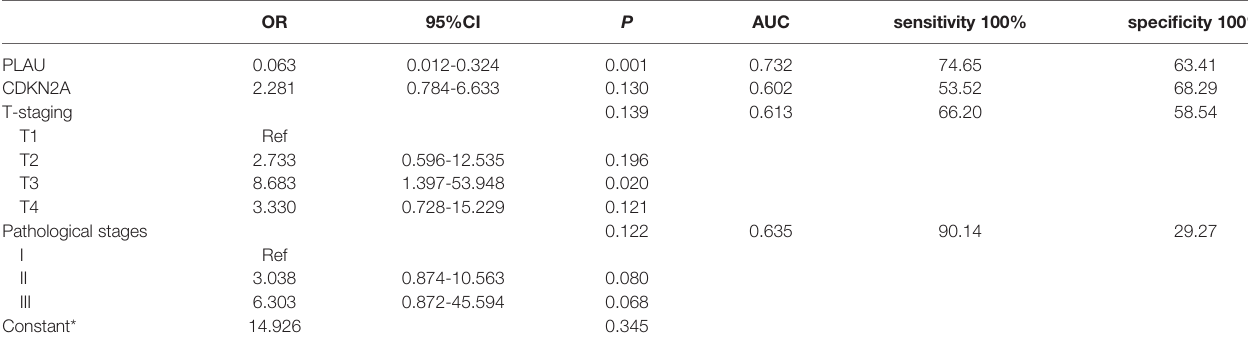
TABLE 3 | Prediction model of neck lymph node metastasis in oral squamous cell carcinoma. OR 95%CI P AUC sensitivity 100% speci fi city